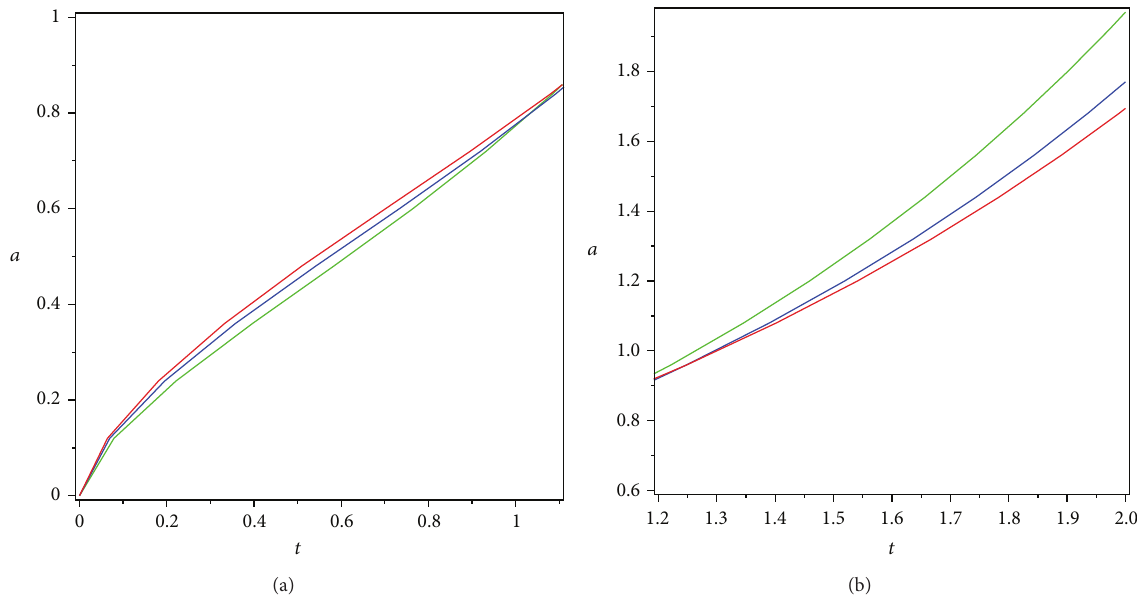
Figure 1: Scale factor versus time for 𝐵 = 3 and 𝐴 = 1/3 . 𝛼 = 0.1 (green line), 𝛼 = 0.5 (blue line), and 𝛼 = 0.9 (red line).